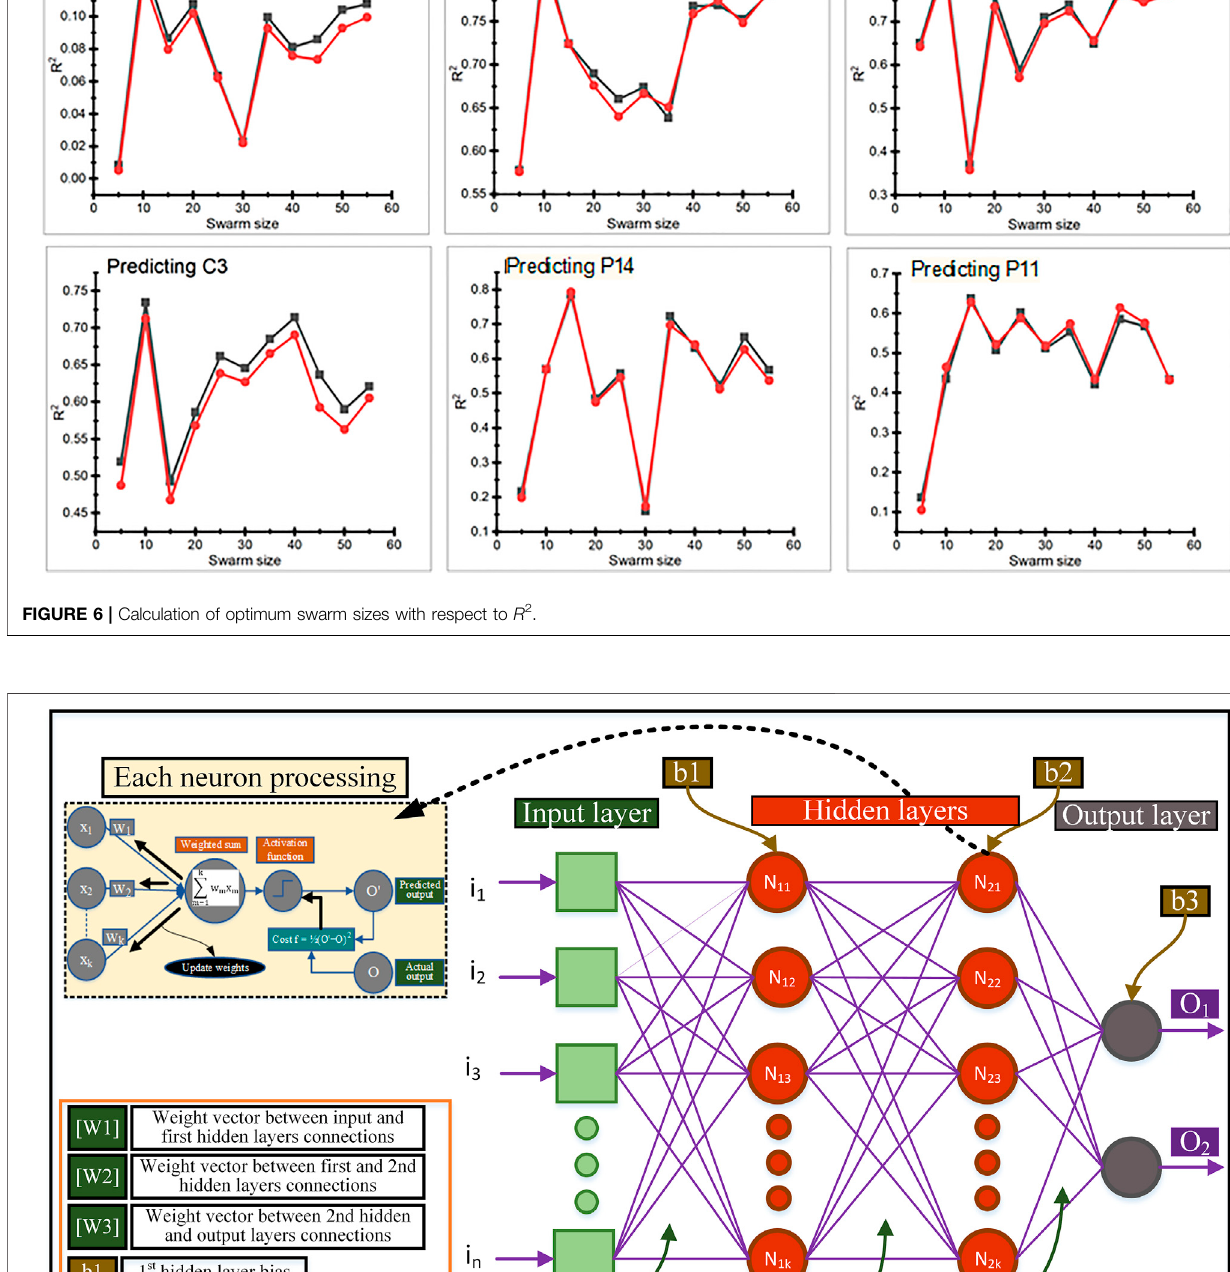
Frontiers in Energy Research |